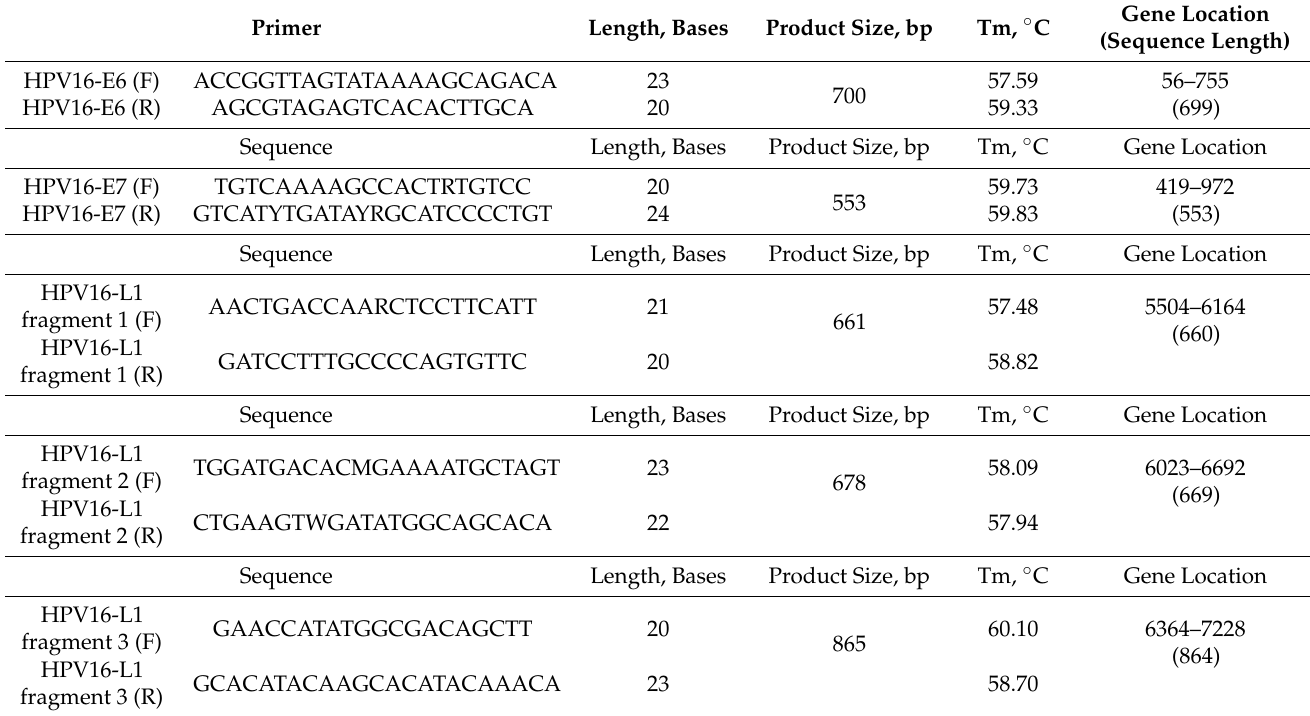
Table 2. The bands resulting from the amplified products were compared visually after gel electrophoresis. Table 3. In-house target-specific primers for HPV16 E6 and E7 and the multiple primer sets for L1.